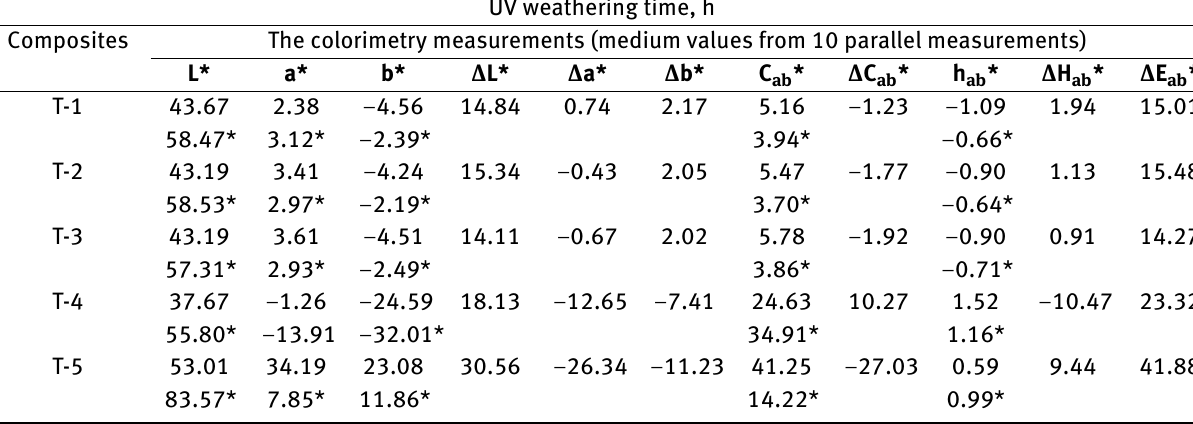
Table 5: Colour parameters of WPCs samples before and after* UV weathering